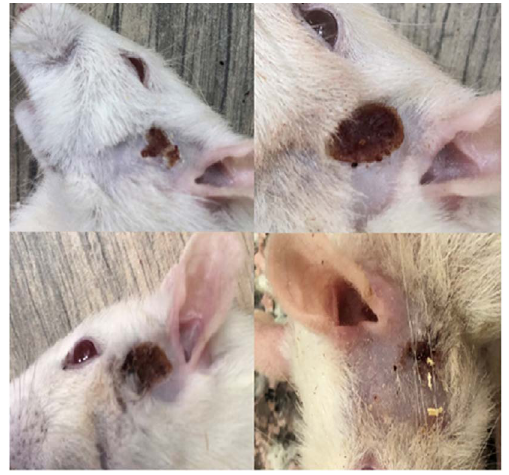
Fig. 4. Samples of burnings caused by 171J/cm2 laser therapy Table 9. Head circumferences comparison in day